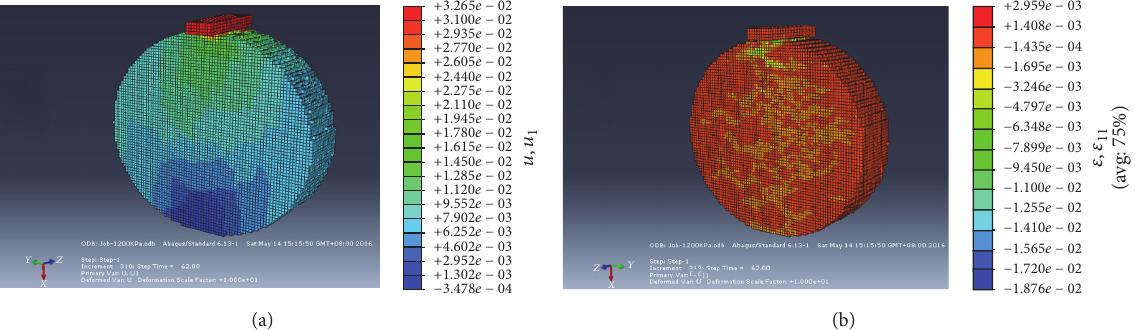
Figure 9: Displacement and local stain distribution of the digital sample (time steps = 62), (a) vertical displacement 𝑢 1 and (b) local normal strain 𝜀 11 .